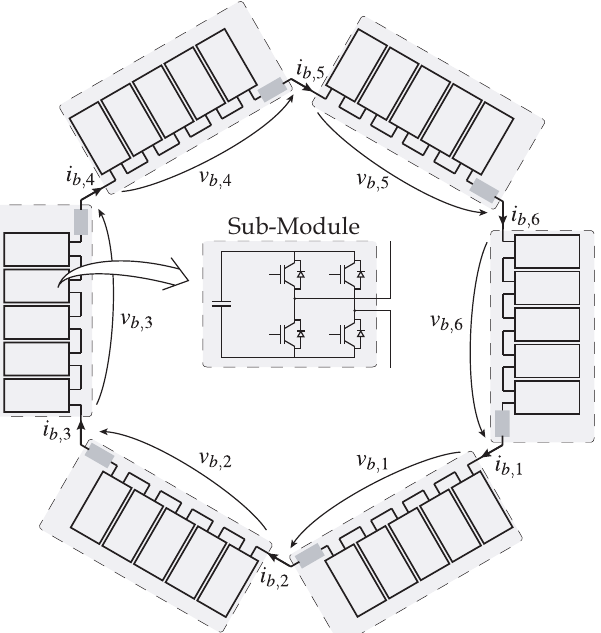
Figure 1. Hexverter topology depicting the connections between the six arms and the sub-module’s H-bridge